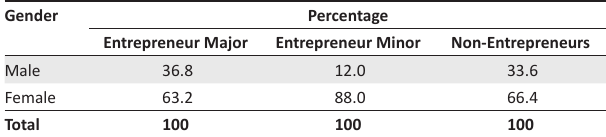
TABLE 2: Gender per student